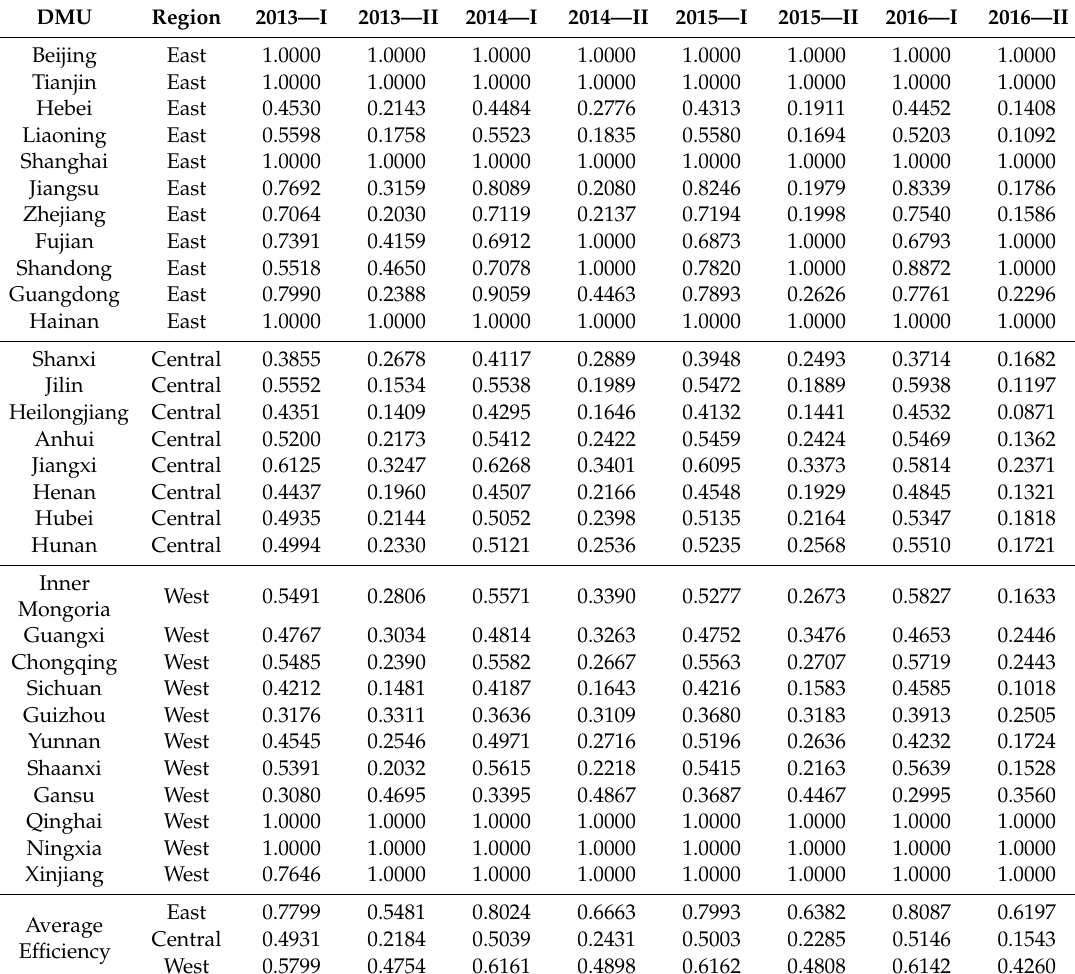
Table 4. Two-stage total e ffi ciency score during